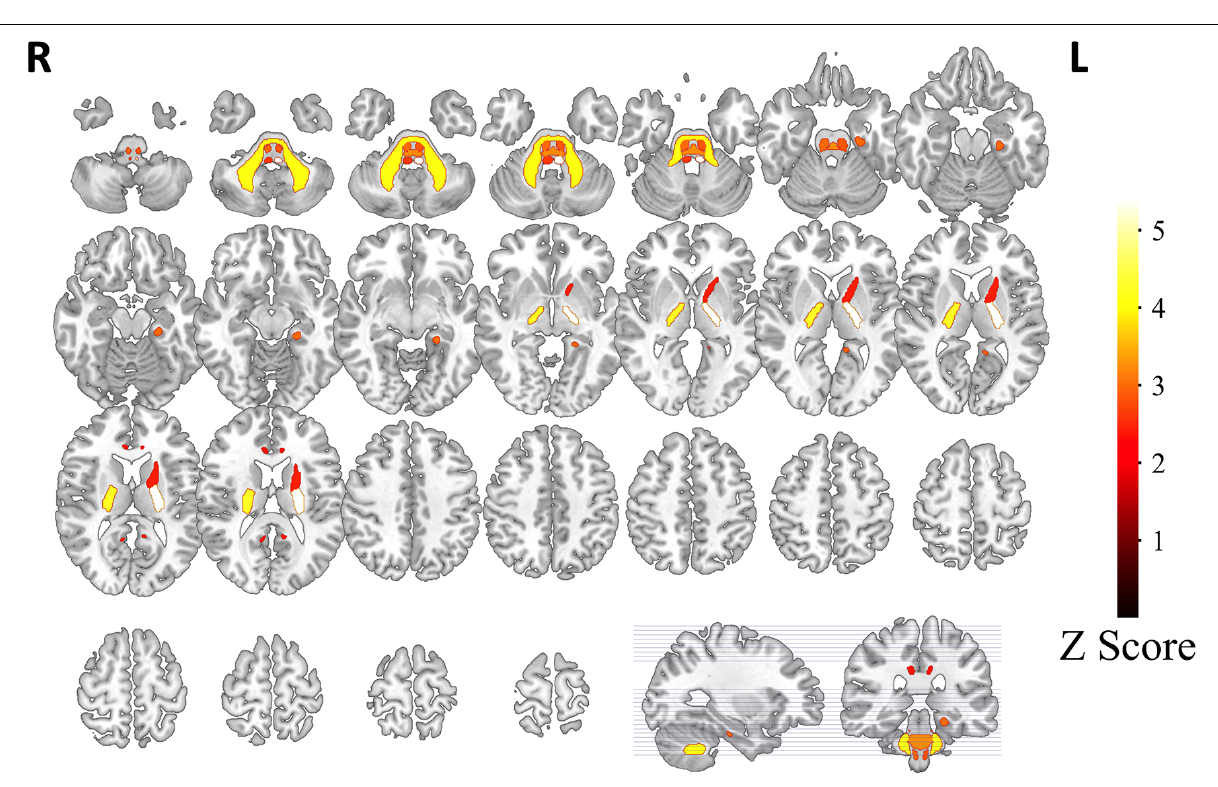
FIGURE 2 | White matter tracts related with gait indices. Based on white matter hyperintensities extracted from every white matter tract, patients are separated into two groups. White matter tracts with significant gait index differences (indicated as z -scores in the graph) in the two groups are represented. Tracts with a hotter color have stronger relationships with gait